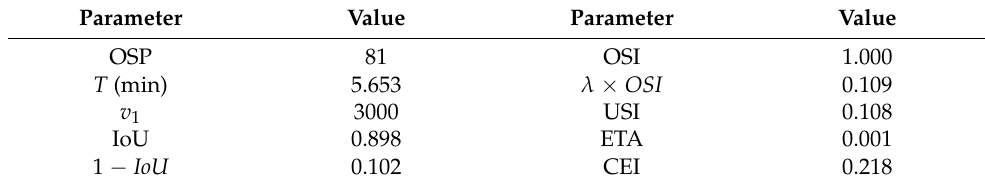
Table 5. Segmentation evaluation parameters of fusion image without atmospheric correction.